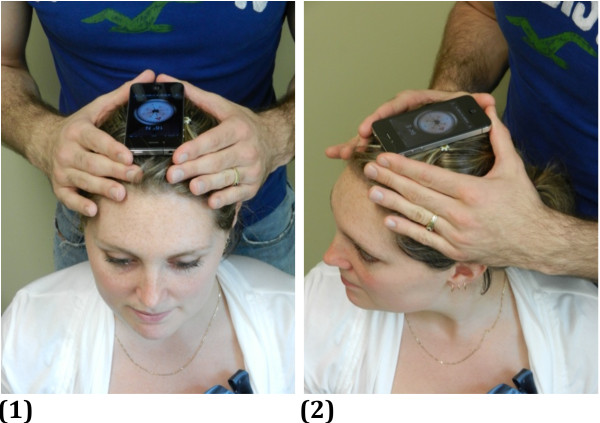
Position of the iPhone for the measurement of right rotation. (1) Starting position. (2) Position at end range of right rotation. iPhone’s cover is fixed on the head, compass aligned in front with the nose.